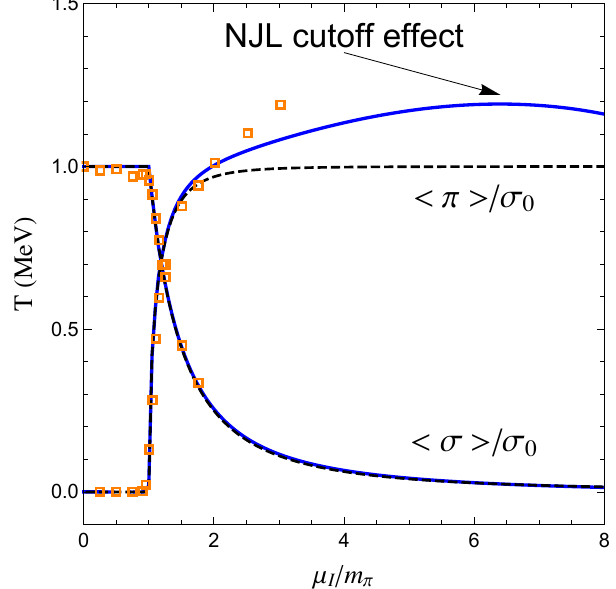
Figure 7. Comparison of the chiral and pion condensates obtained by χ PT (dashed black line), by the two-flavor NJL model (solid blue line) and by LQCD simulations on a 6 24 3 lattice by [133] (orange × squares). The condensates have been normalized at the value of the scalar condensate in the normal phase (note that the LQCD data of [133] have been obtained at T = 113 MeV), while the chemical potential is in units of the pion mass in the normal phase. Quite remarkably, the condensates obtained with the three methods overlap for µ I 2 m π . For larger values of the isospin chemical potentials the ≤ evaluation of the pion condensate becomes problematic: the NJL model feels the hard cutoff Λ ; the χ PT approaches the critical scale Λ χ ; the LQCD simulations start to feel the lattice saturation effects